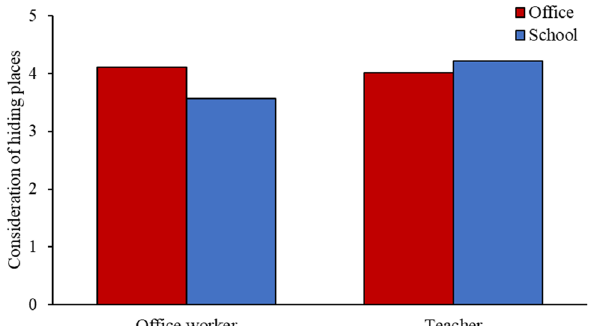
Figure 8. The effect of building × occupation interaction on participants’ consideration of hiding